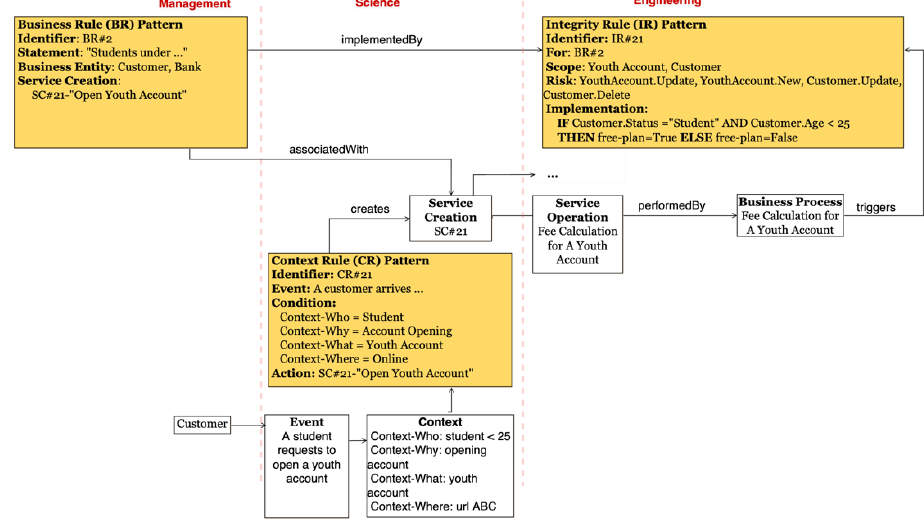
Fig. 5. Example of RuCBS patterns for describing Scenario#2 Scenario#3